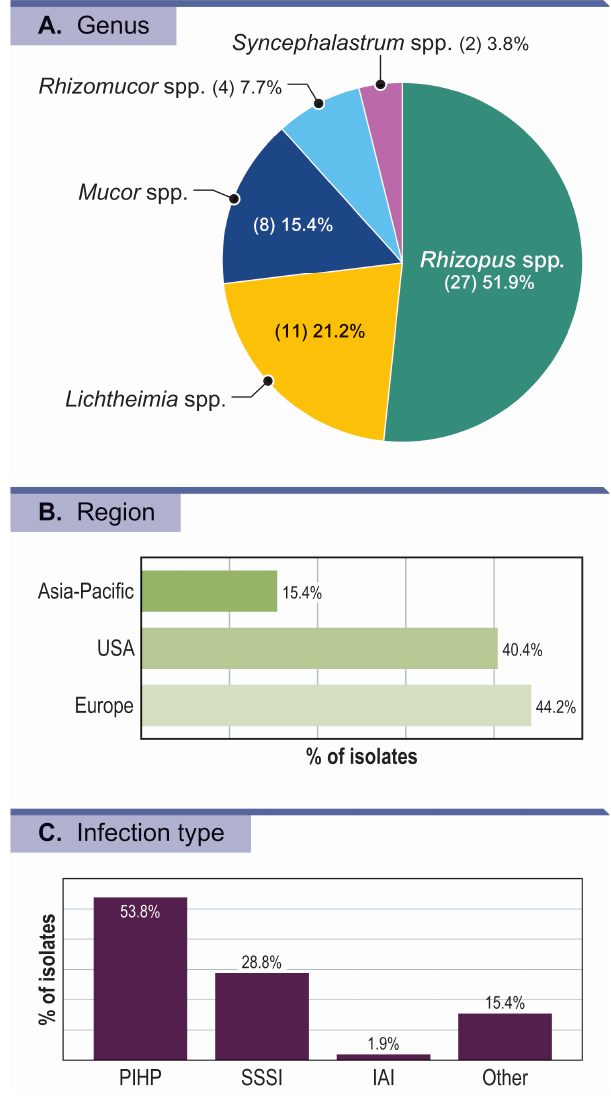
Figure 1. Distribution of Mucorales isolates recovered from invasive fungal infections worldwide (2017–2020). PIHP, pneumonia in hospitalized patients; SSSI, skin and skin structure infection; IAI, intra-abdominal infection.